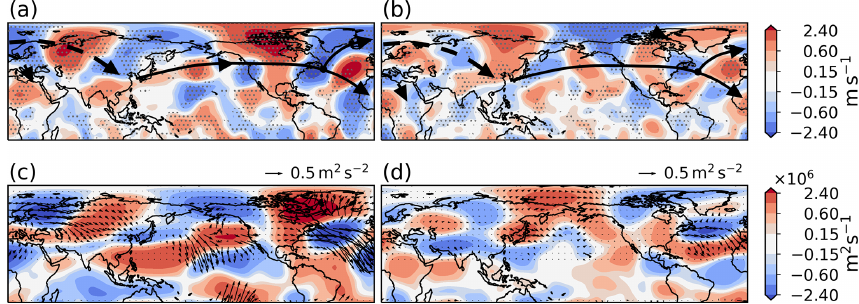
Figure 4. Spatial patterns of MEM anomalies in (a, b) meridional wind speed and (c, d) zonal-mean-corrected streamfunction (shades) and wave activity flux (arrows; computed for regions north of 18 ◦ N) at 250hPa during JF (a, c) and MAM 2020 (b, d) . In (a, b) , black arrows show the suggested path of the Rossby wave train, and stippling indicates where at least 70% of the models agree on the sign of change.